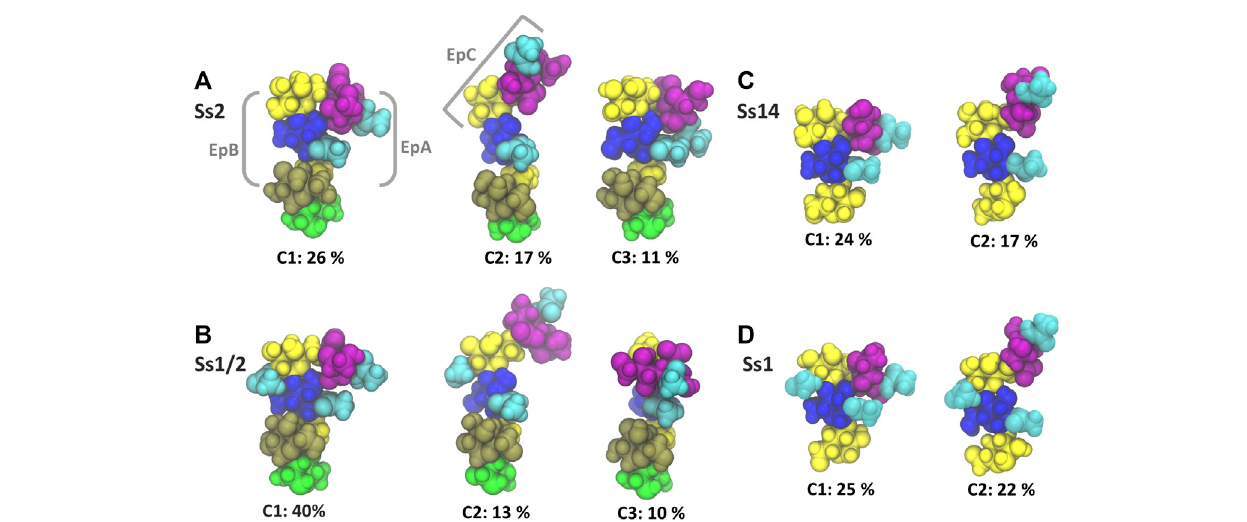
FIGURE 4 | Main conformational families and associated percentages of the side chains in RU 4 for (A) Ss2; (B) Ss1/2; (C) Ss14; and (D) Ss1. Conformational clusters of less than 10% occupancy are not shown. Potential epitopes are labelled on Ss2 in grey. The residues in all representations are coloured in keeping with the SNFG, as follows: β D Gal and β D GalNAc — yellow; α D Gal — brown; β D Glc and β D GlcNAc — blue; β L Rha — green; α D Neu5Ac — purple; NAc —